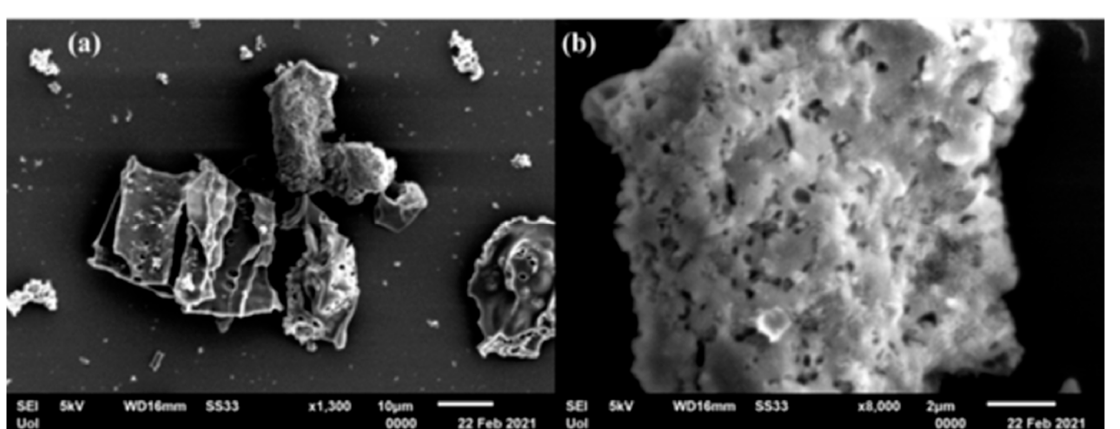
Figure 6. ( a ) AFM image of cross-sectional analysis of selected carbon nanosheet in PC sample, ( b ) AFM statistical analysis of thickness for 30 randomly selected nanosheets.